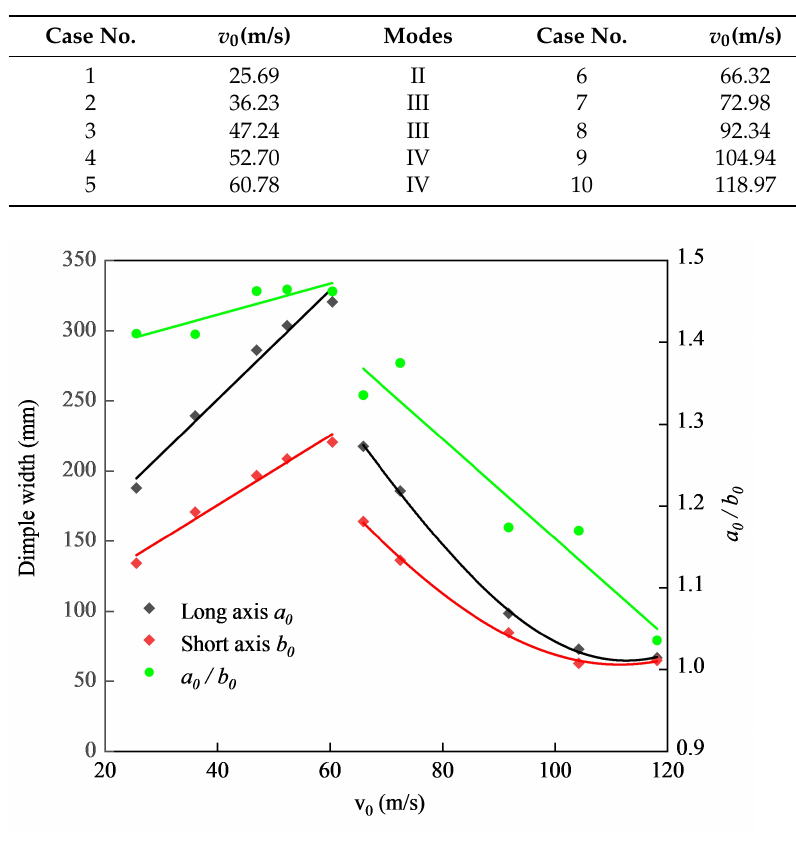
Figure 5. Dual axes of the dimple boundary that changed with impact